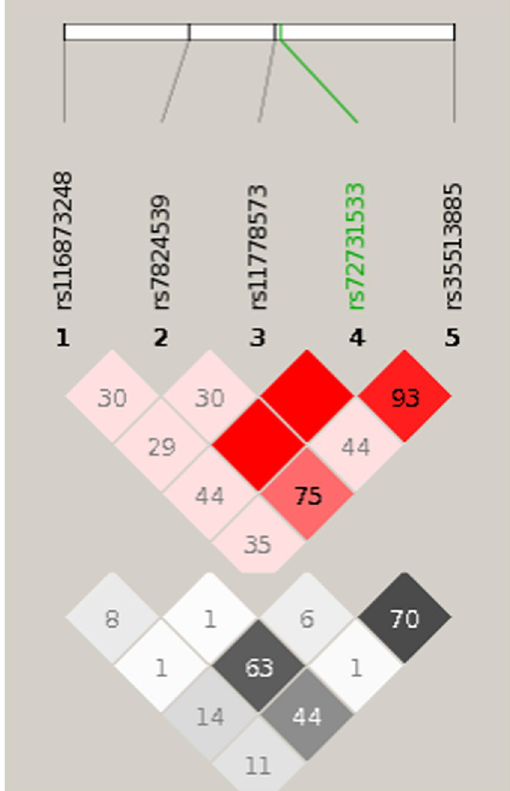
Figure 3. Linkage disequilibrium(D’ top, r 2 bottom) structure for all associated SNPs. For both (D’ and r 2 , values range from 0 (no LD) to 100 (complete LD). The thick white line represents a strand of a chromosome. The black bars on the white line of the chromosome are SNPs that have been identified and sequenced. These SNP locations are labeled in this picture from 1 to 5. Each of these SNPs has a name with corresponding numeric code. Each SNP is represented by a labeled grey triangle below the thick white line. Value in each box indicates (D’ or r 2 value between 2 SNPs (intersection). For (D’ figures, no value indicates complete LD (100).